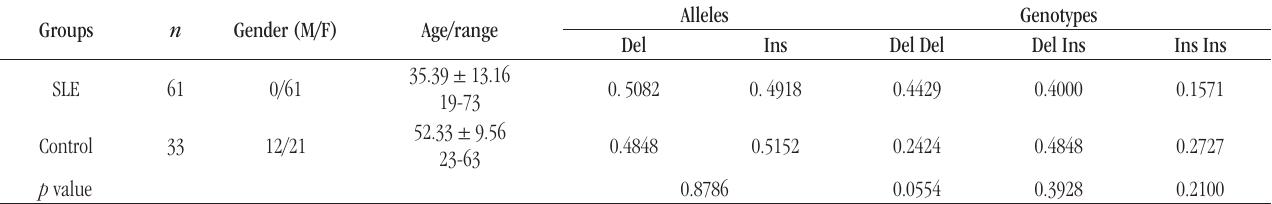
Alleles Genotypes Del Ins Del Del Del Ins Ins Ins